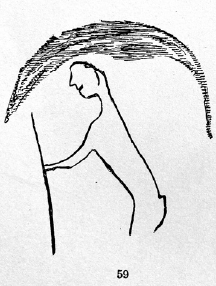
Figure 23. “Old Cloud” signature in Red Cloud’s census, Pine Ridge Agency, Dakota Territory, 1884 (Publ. in Mallery 1886, 1893).